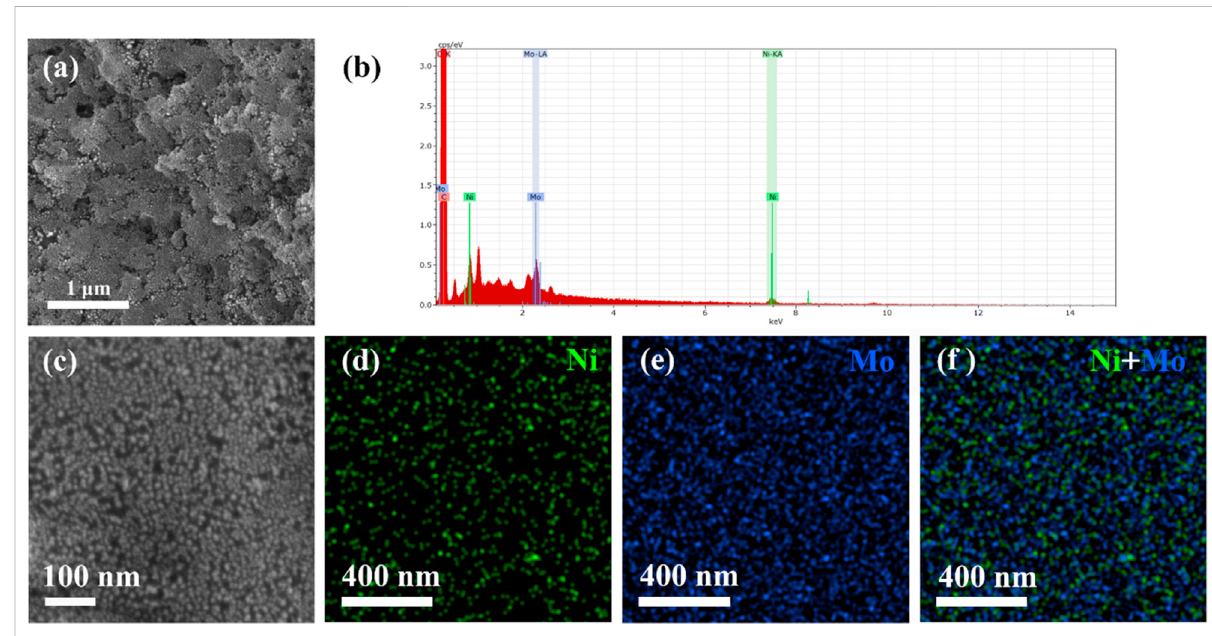
FIGURE 1 Structural characterization of Ni 4 Mo/AC. (A,C) SEM image. (B) EDS spectrum. (D – F) EDS elemental mapping of Ni and Mo in Ni 4 Mo/AC.